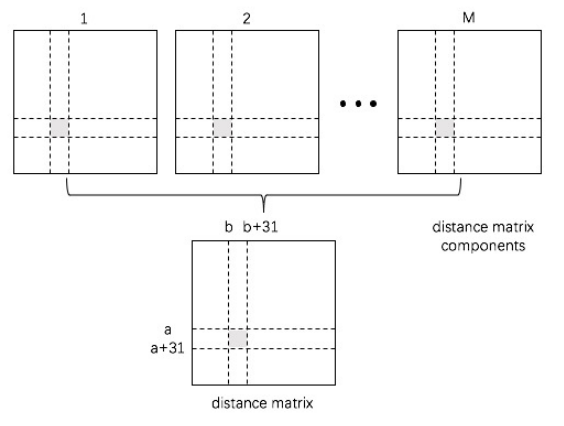
Fig. 1. The sketch of the parallelization strategy on GPU for calculating the distance